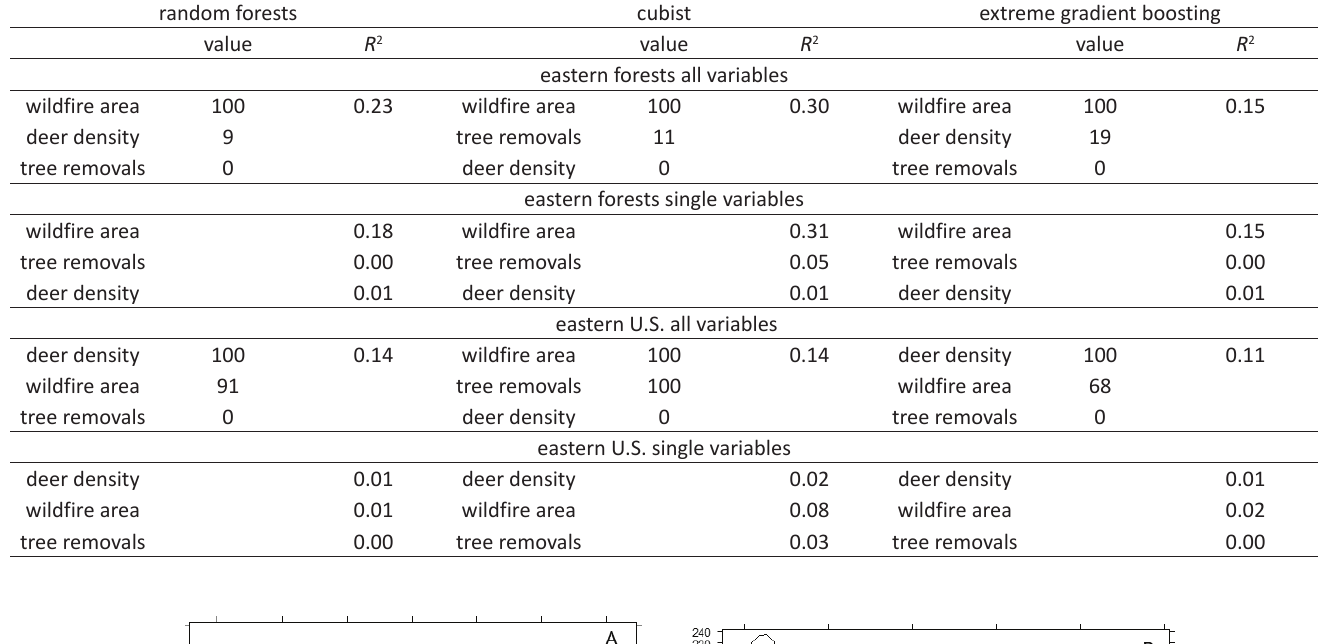
Table 1 . Most important variables, importance value, and R2 (predictions of withheld samples) for random forests, cubist, and extreme gradient boosting models of non-native plant richness in eastern forests and the eastern United